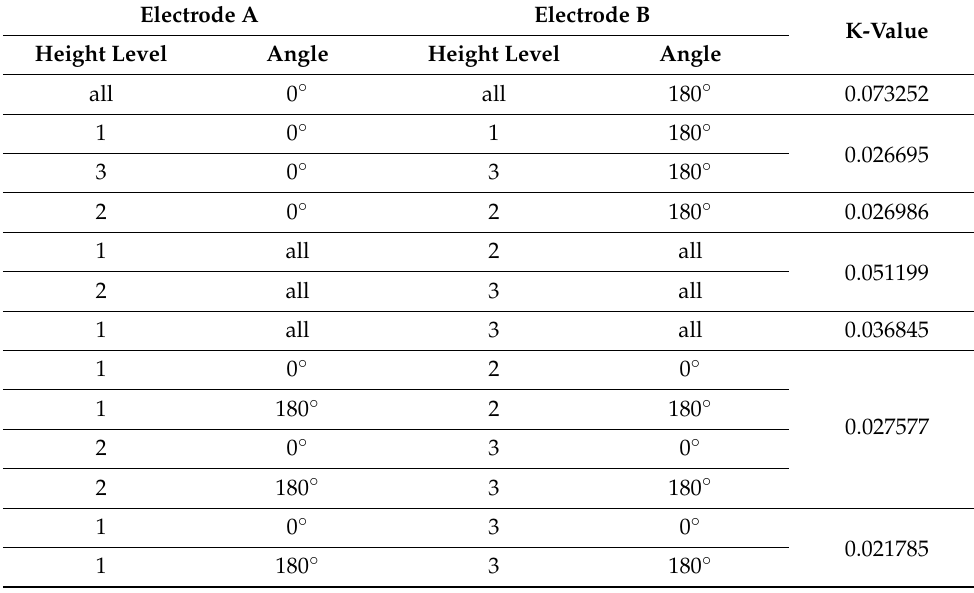
Table A1. Geometry factors k for the validation tests of the test setup, calculated by Comsol, with an electrode array with angular distances of 180 ◦ and the electrical conductivity of the electrodes in Comsol model of titanium of 2.5 × 10 6